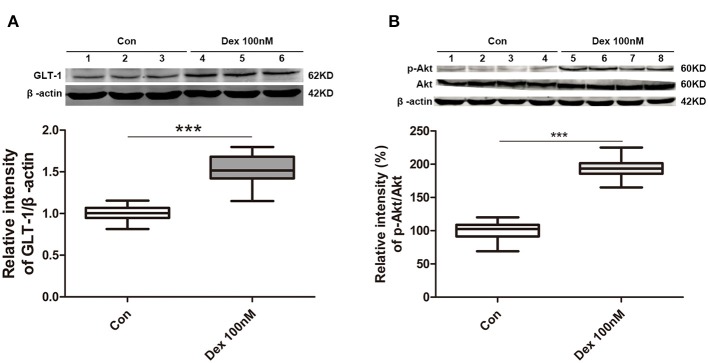
Dexmedetomidine upregulated GLT-1 expression and the levels of phospho-Akt/Akt in primary astrocytes. (A) Dexmedetomidine significantly upregulated GLT-1 at 100 nM for 30 min (p < 0.001). (B) Phospho-Akt was obviously increased after of dexmedetomidine treatment and the ratio of p-Akt/Akt in Dex group was increased (p < 0.001). Box plots show the median, interquartile, and range, considering control group mean values as 100% (n sample = 12 cell wells per group, 3 independent cell preparations were performed). ***p < 0.001 vs. Control group.